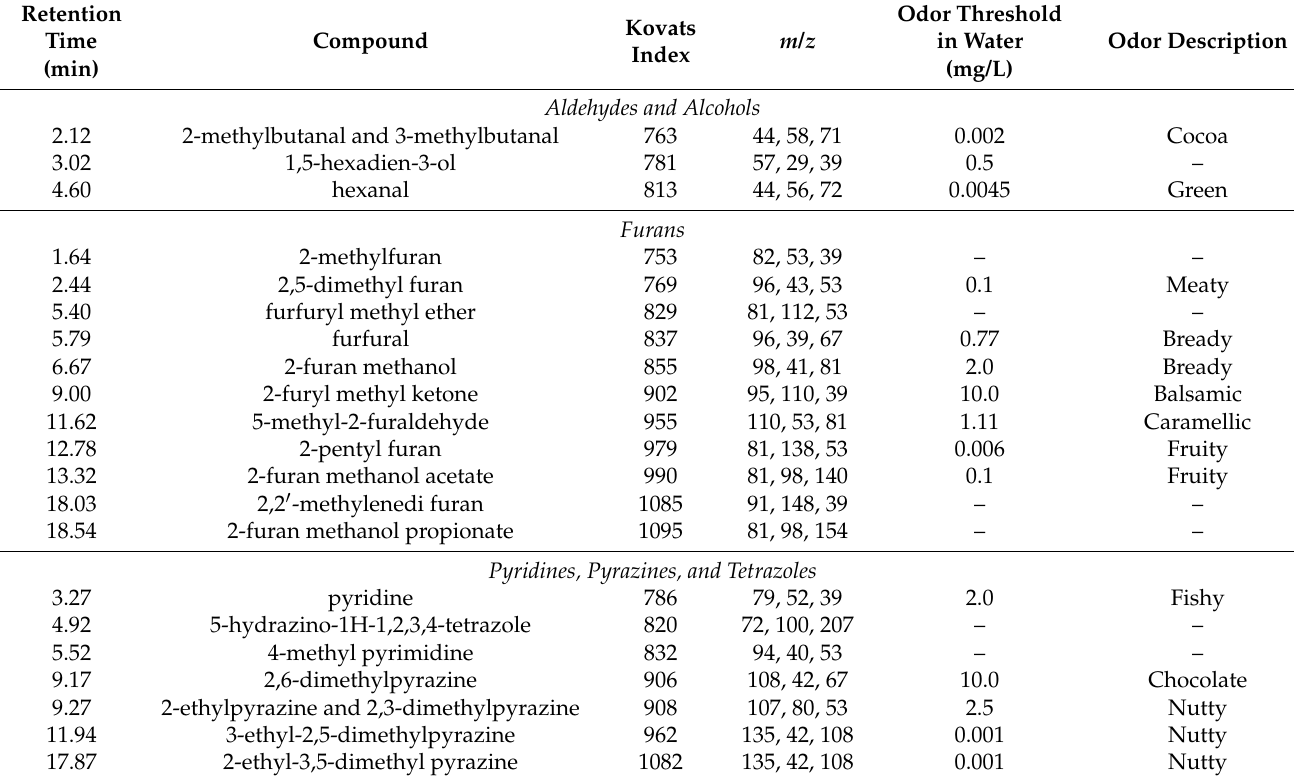
Table 1. Volatile compounds identified in the ready-to-drink coffee and their respective retention times (RT), Kovats index, odor threshold in water, and primary odor